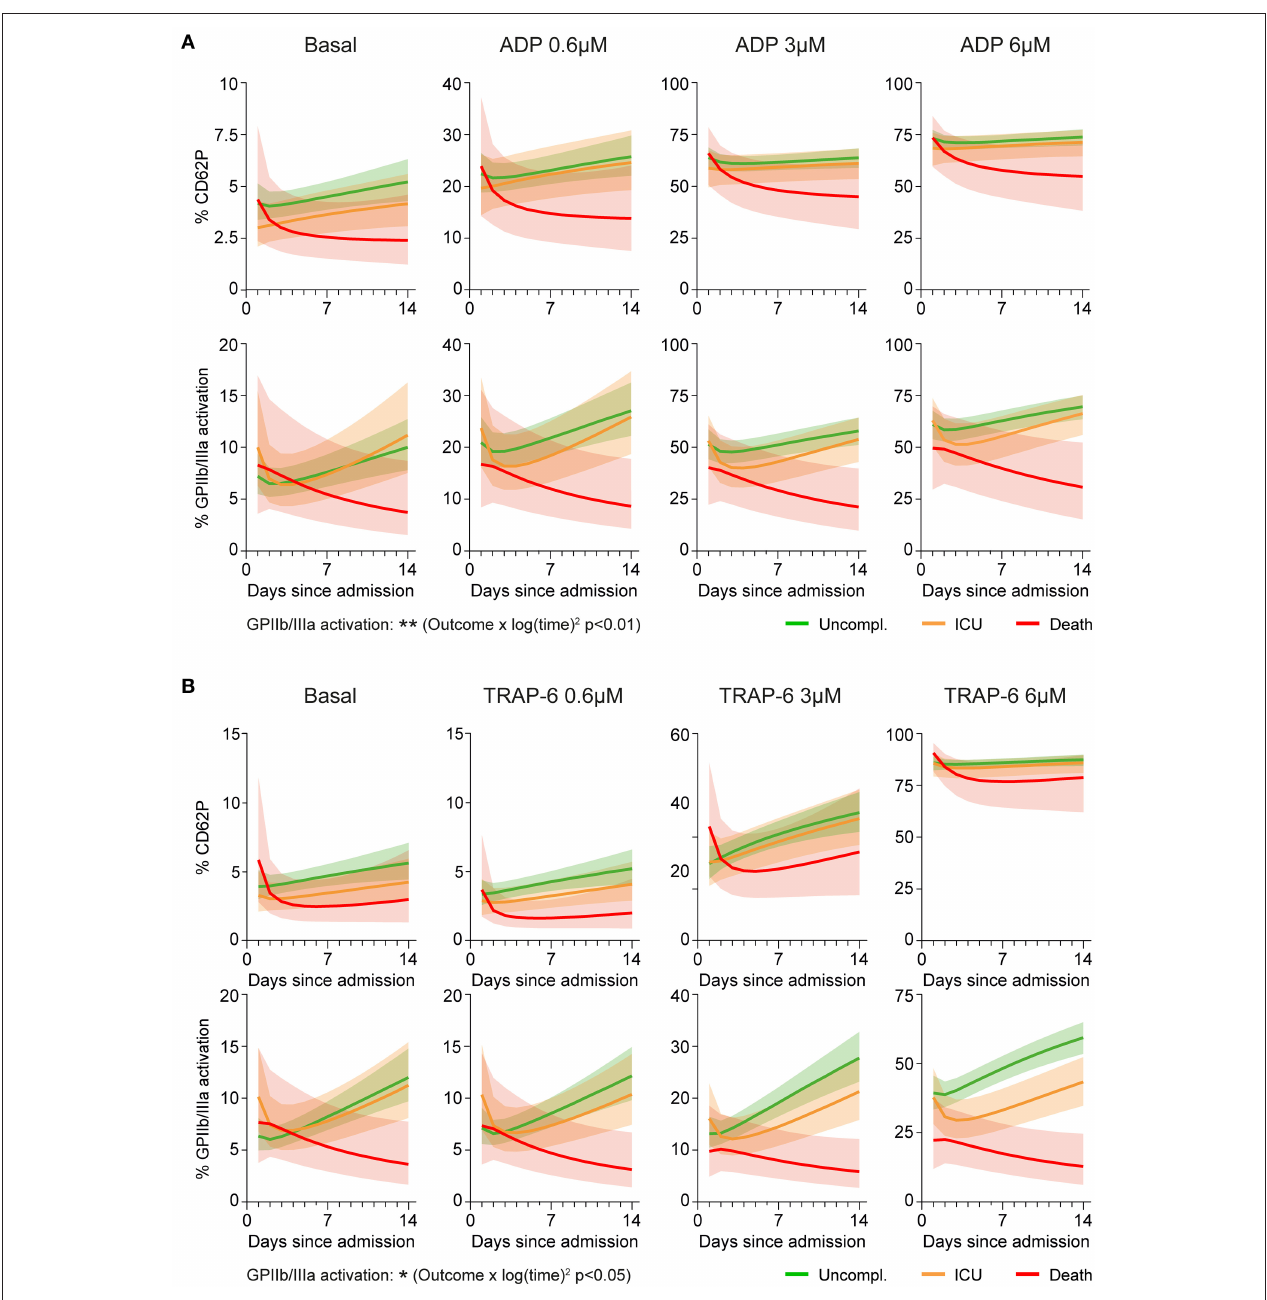
FIGURE 2 | Aggravating platelet hypo-responsiveness in fatal COVID-19 abrogates GPIIb/IIIa activation. Platelet activation at basal condition and in response to agonist stimulation (0.6–6 µ M; 15min) was monitored in 97 patients during hospitalization by determining surface CD62P expression and GPIIb/IIIa activation (PAC1 antibody binding). A mixed model approach was used to estimate the different kinetics of platelet activation and reactivity over time between patients with different outcomes. The model was applied independently to explore (A) ADP-triggered CD62P expression (upper panel), ADP-triggered GPIIb/IIIa activation (lower panel), (B) TRAP-6-triggered CD62P expression (upper panel) and TRAP-6-triggered GPIIb/IIIa activation (lower panel). Lines indicate central tendencies of patient groups with their 95% confidence intervals (shaded areas). n = 97 patients. * p < 0.05, ** p < 0.01.